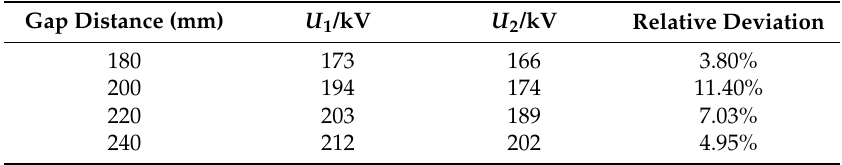
Table 1. Test data of impulse